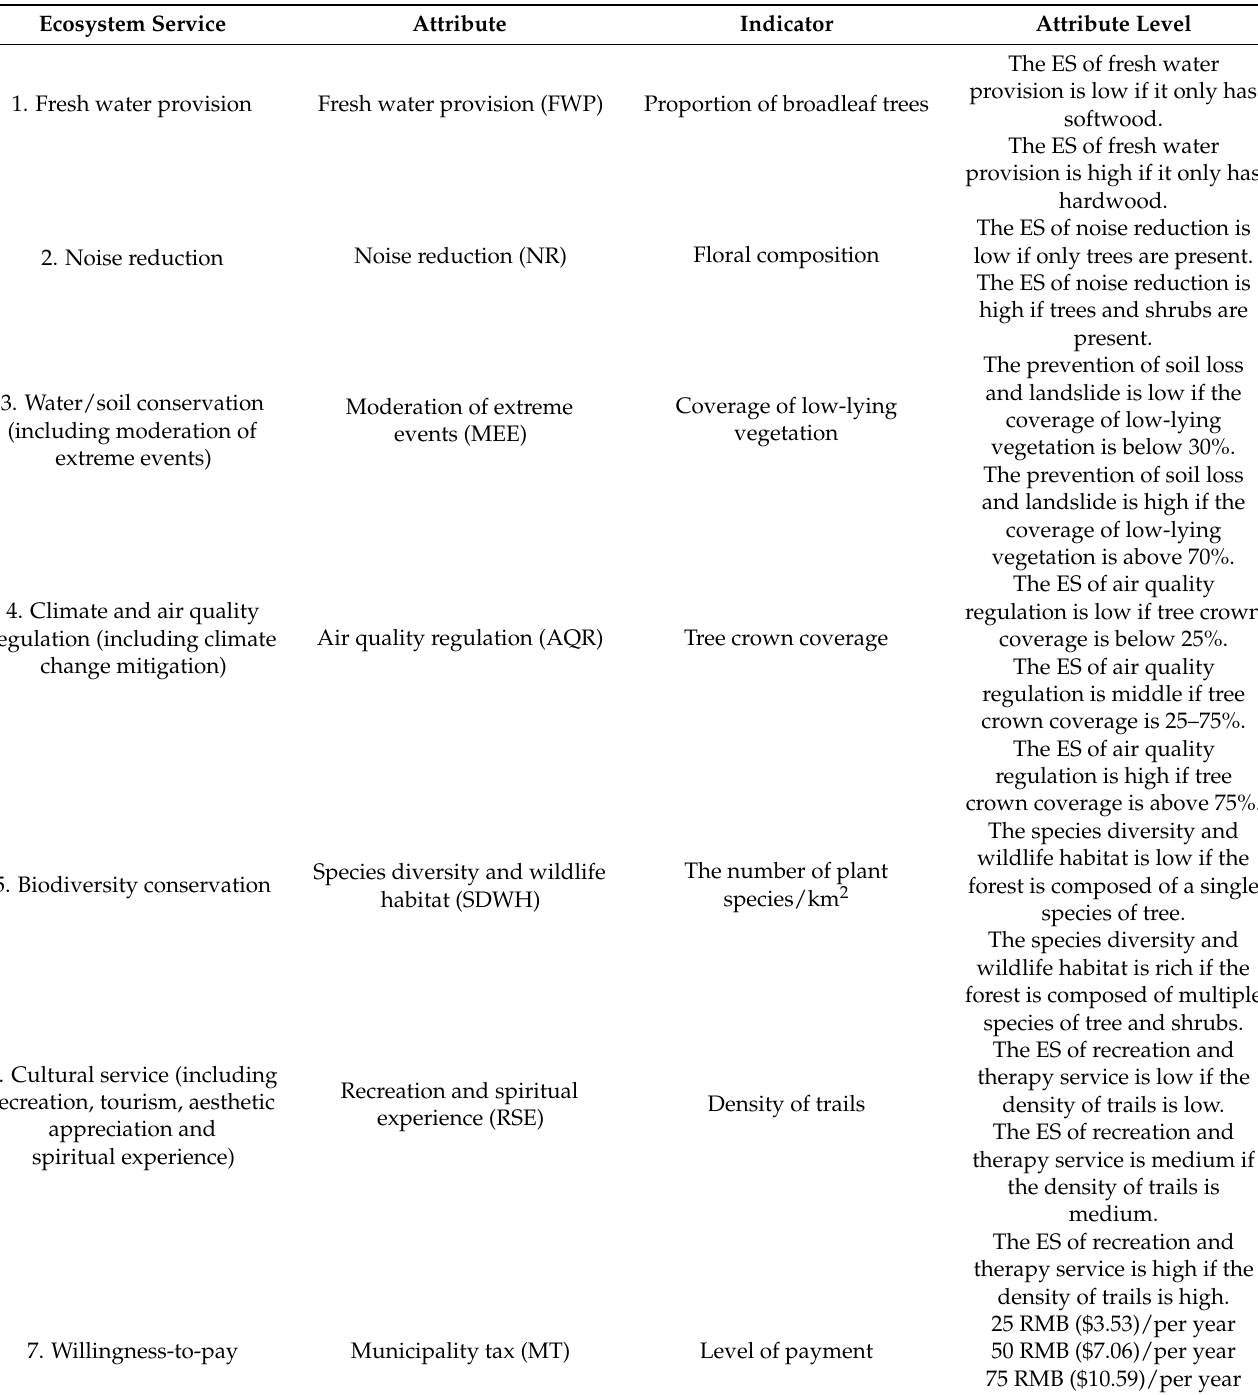
Table 4. The attribute, indicator, and attribute level for